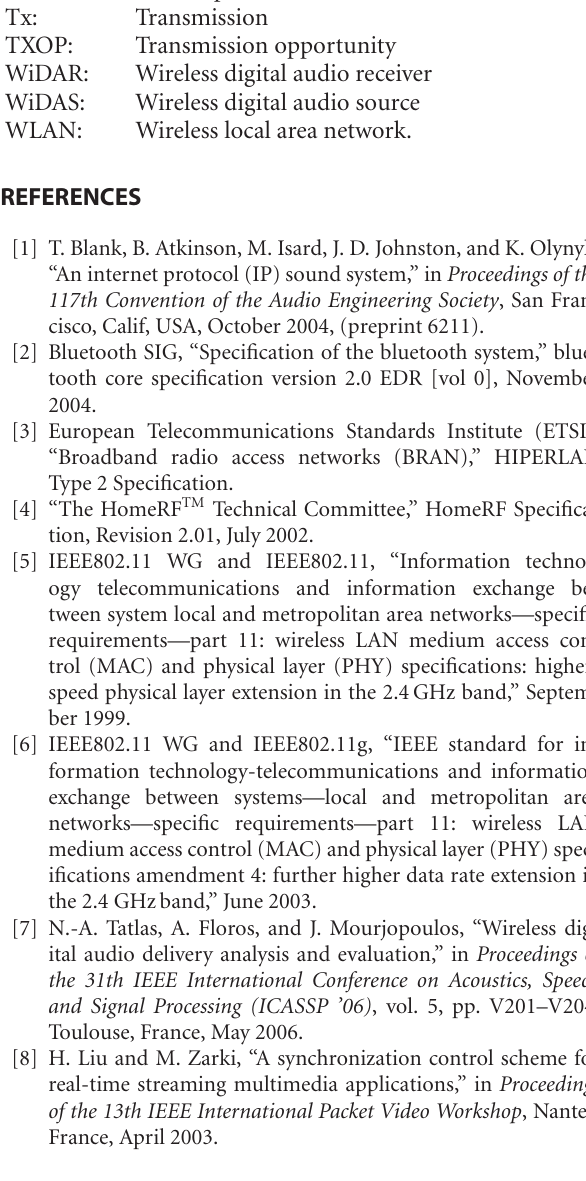
Figure 15: Delayed throughput for digital WLAN audio